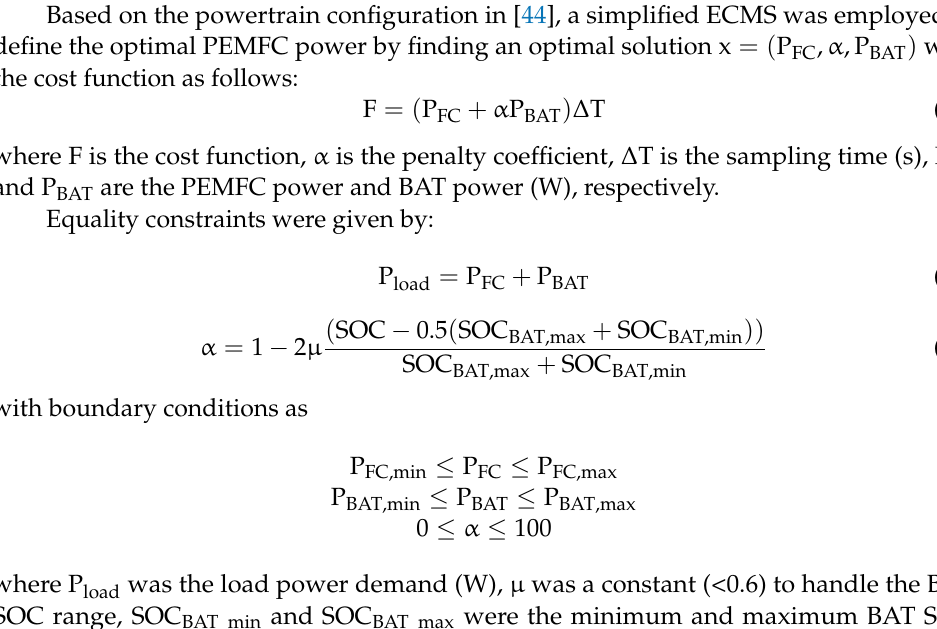
Figure 5. Driving cycle of the hybrid tramway [19,20,33,45].